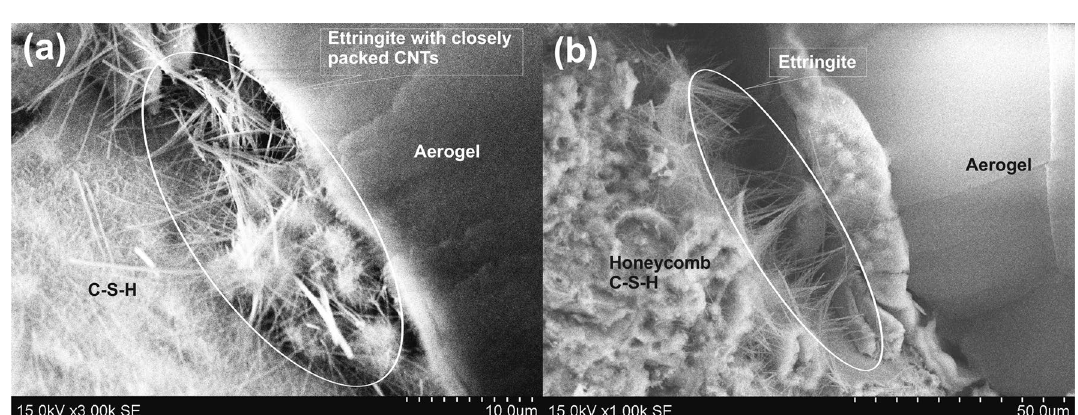
Figure 6. ( a ) Separation gaps between aerogel and cementitious material in the transition zone, ( b ) good adhesion of expanded glass aggregates with cementitious material.